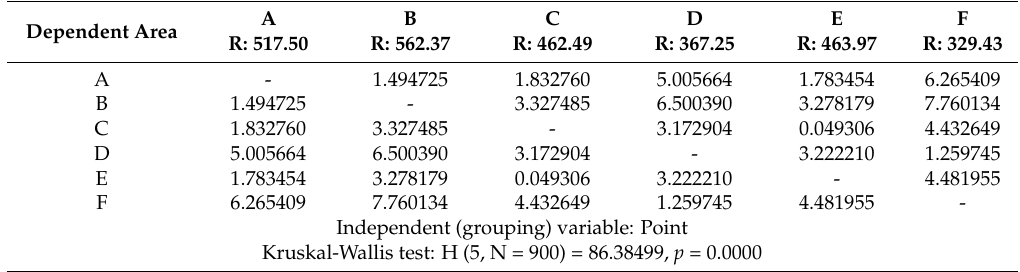
Table 6. Multiple comparisons z ’-values of area values for point variable.